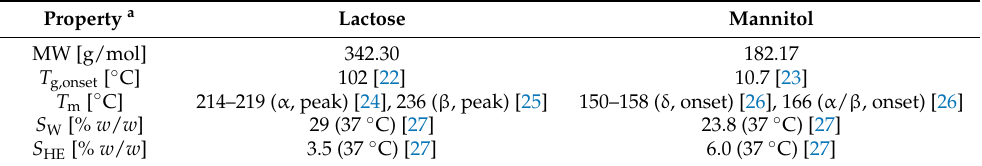
Table 1. Properties of materials used in the current